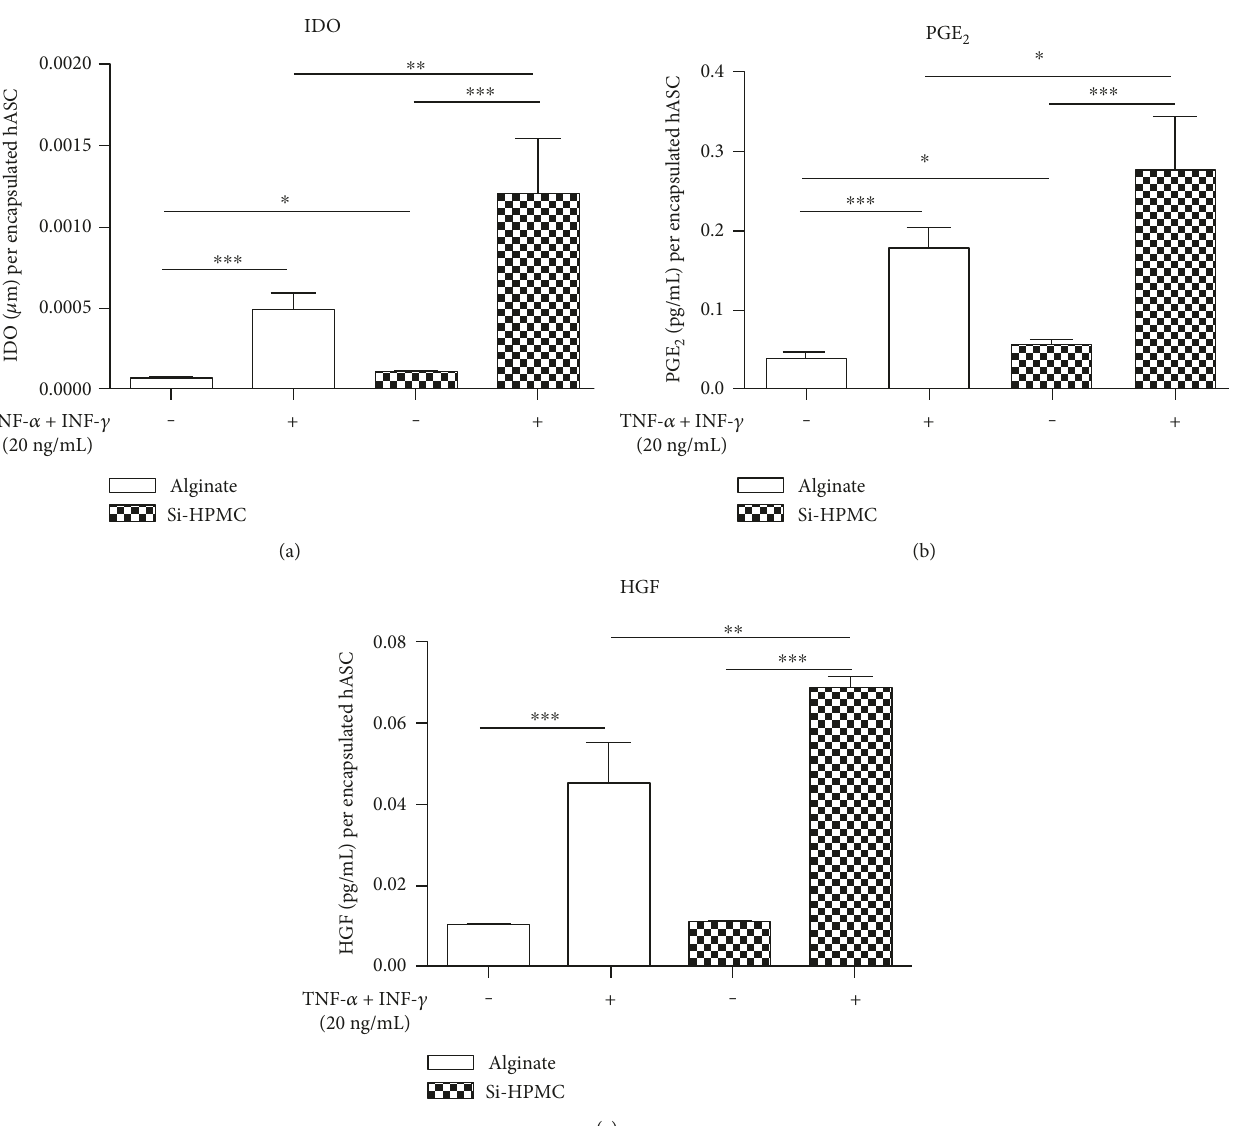
Figure 5: IDO enzyme activity and PGE and HGF concentrations in supernatants of encapsulated hASC. One week after encapsulation in 2 alginate and Si-HPMC, hASC were stimulated (or not) with TNF- α and IFN- γ (20 ng/mL each) for 72h. For each condition, twenty alginate or Si-HPMC particles were then disrupted and encapsulated hASC were counted. IDO enzyme activity (a) was measured by tryptophan-to- kynurenine conversion with photometric determination of kynurenine concentration in the supernatant. PGE (b) and HGF (c) were 2 measured in cell supernatant using ELISA kits according to the manufacturer ’ s recommendations. The secretion of these biofactors was normalized to the number of encapsulated hASC in both alginate and Si-HPMC particles. Alginate and Si-HPMC particles of 1 mm diameter were selected for this study. ∗ p < 0 05 , ∗∗ p < 0 01 , and ∗∗∗ p < 0 001